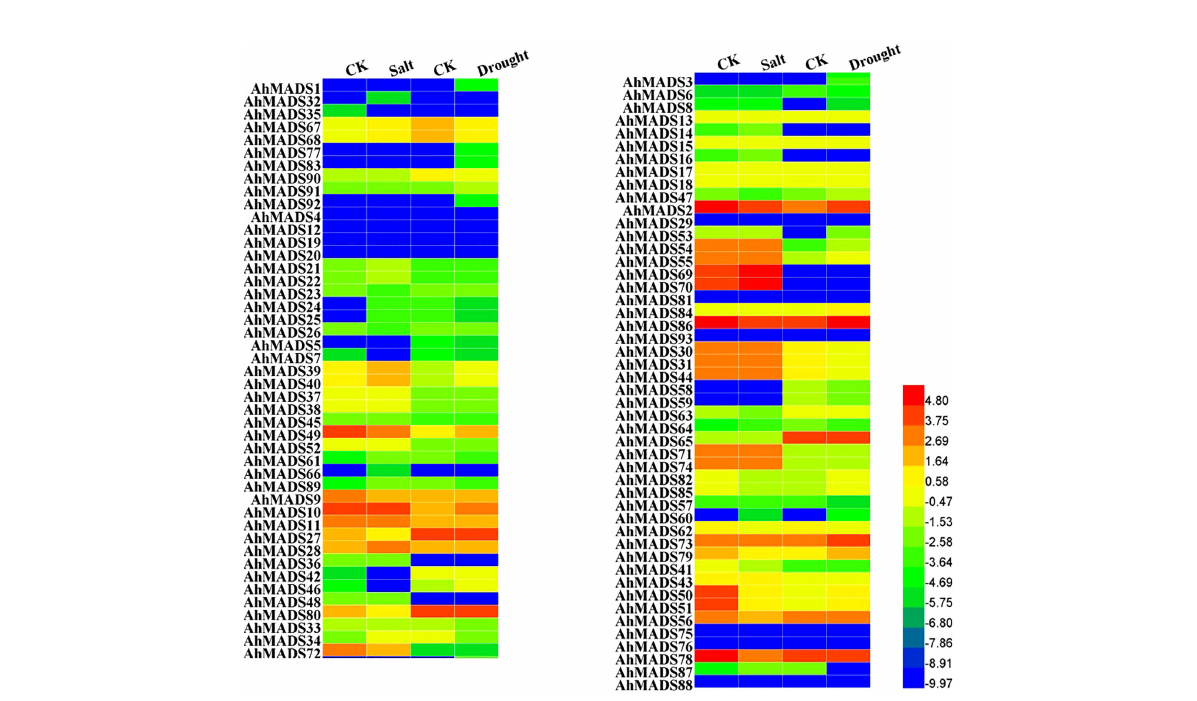
FIGURE 8 Expression levels of MADS-box genes under salt and drought stress treatments in peanut. The FPKM values of the peanut MADS-box genes were log2-transformed to create the heatmap using Heml software. The blue and red colors represent the expression levels of AhMADS genes from low to